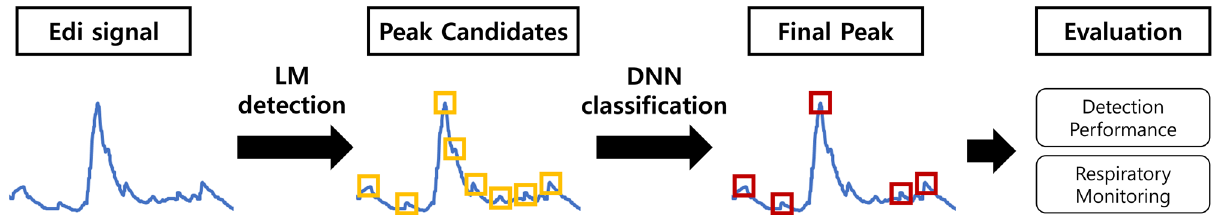
Figure 2. Overview of the respiration analysis algorithm with Edi peak detection.